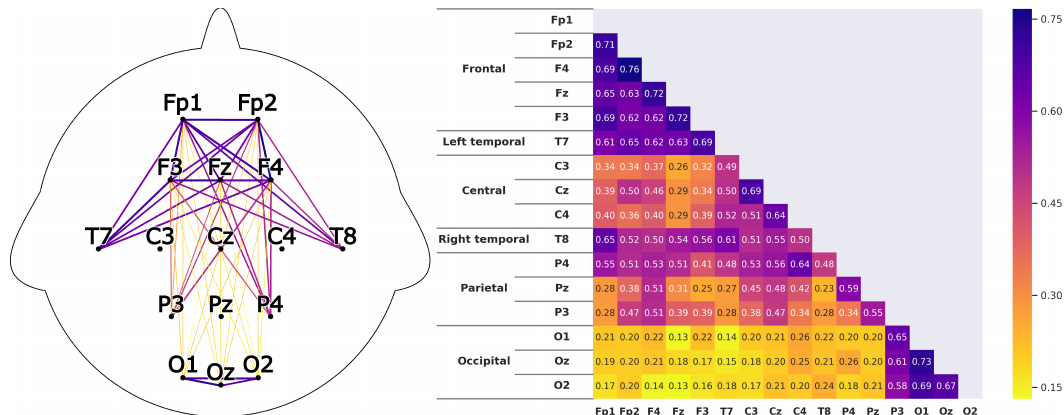
Figure 11. Correlations as described in Figure 8 for the BSC process owner.